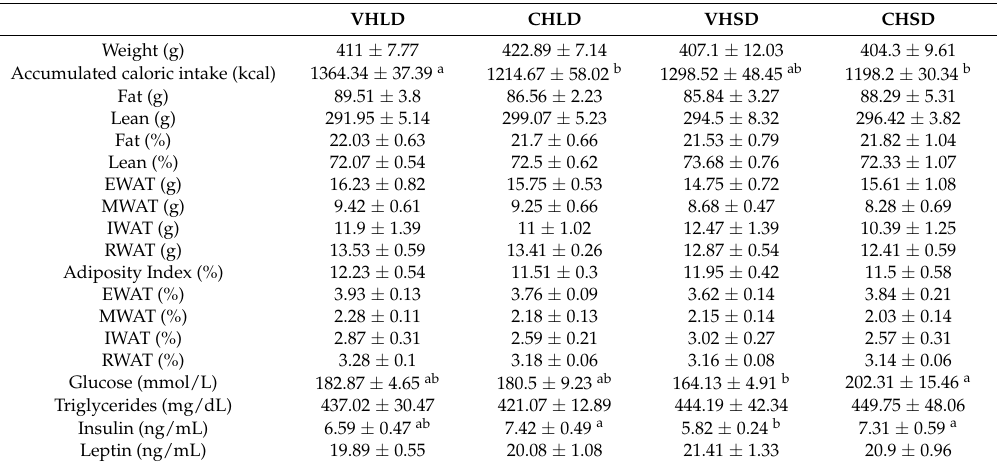
Table 2. Biometric and plasmatic measurements of rats supplemented with cherry or vehicle and a cafeteria diet in long-day and short-day